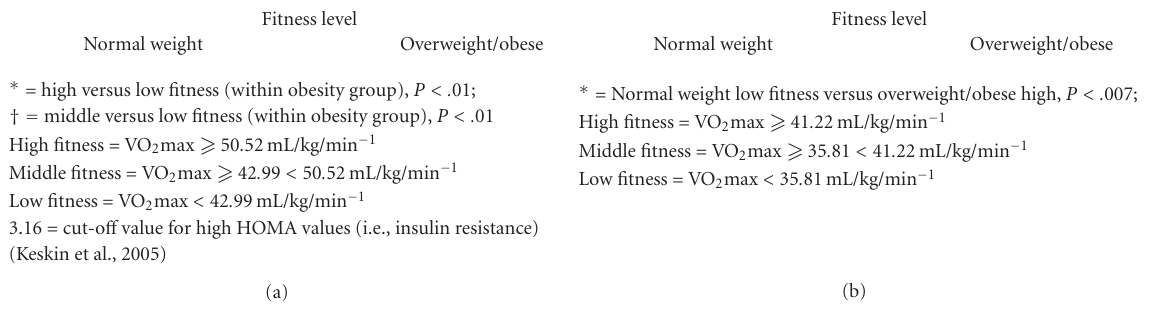
Figure 1: The relationship between aerobic fitness, obesity level and HOMA levels in boys and girls. Table 3: Regression analysis of the relationship between waist circumference, VO 2 max, BMI, and lnHOMA by gender, while controlling for age and